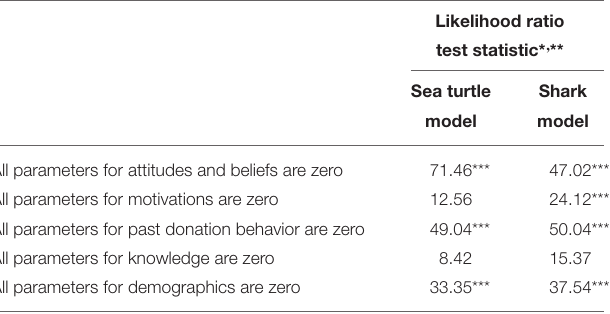
TABLE 4 | Joint significance of the explanatory variables of the multinomial logit